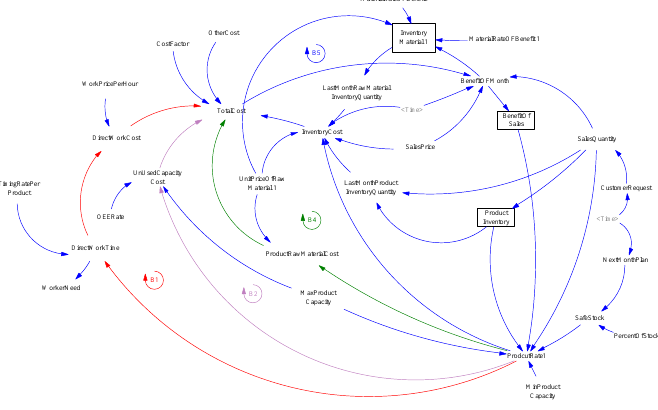
Fig. 1. The preliminary framework of the